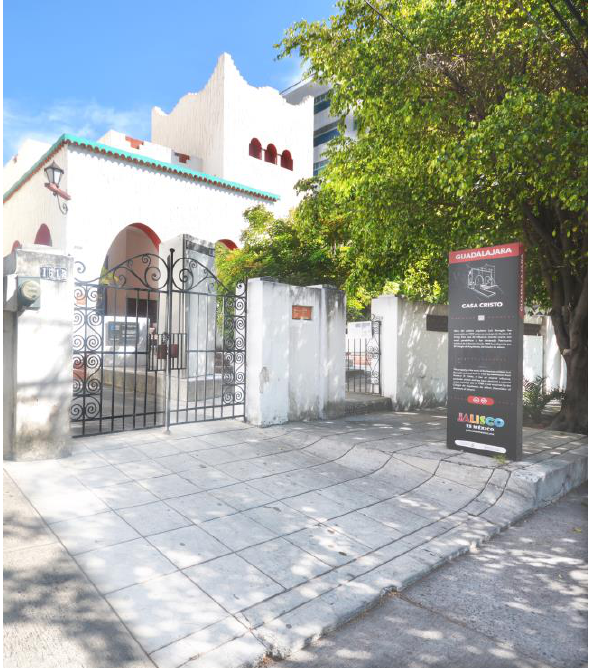
Fig.3 Casa Cristo by Luis Barragán. Photo taken by Davide Mezzino with a Nikon D800 DSLR camera with 50 mm